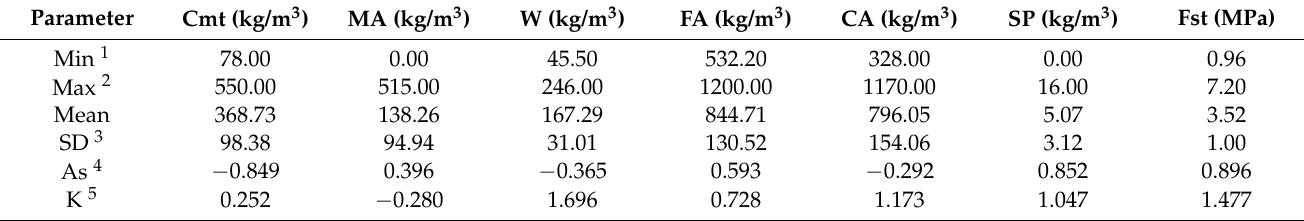
Table 2. Minimum, maximum, mean, standard deviation, skewness, and kurtosis of the input and output